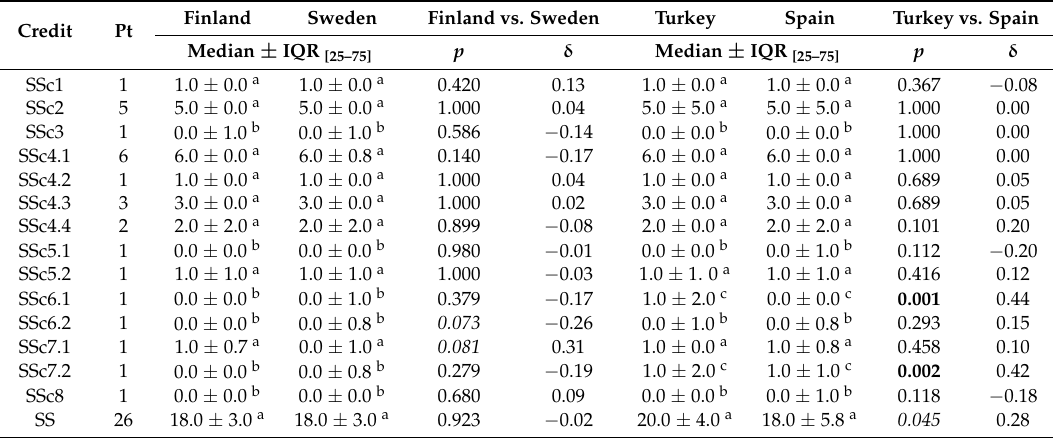
Table 3. SS achievement: Northern European countries vs. southern European